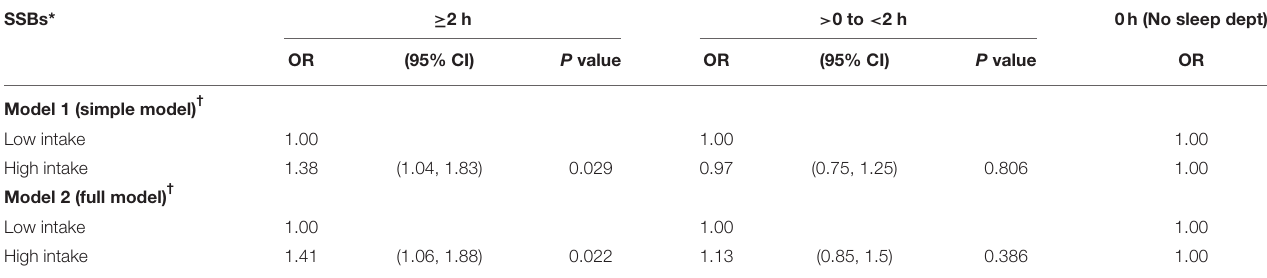
TABLE 5 | Multinomial logistic regression analysis for the sleep debt. SSBs* ≥ 2 h > 0 to < 2 h 0h (No sleep dept) OR (95% CI) P value OR (95% CI) P value